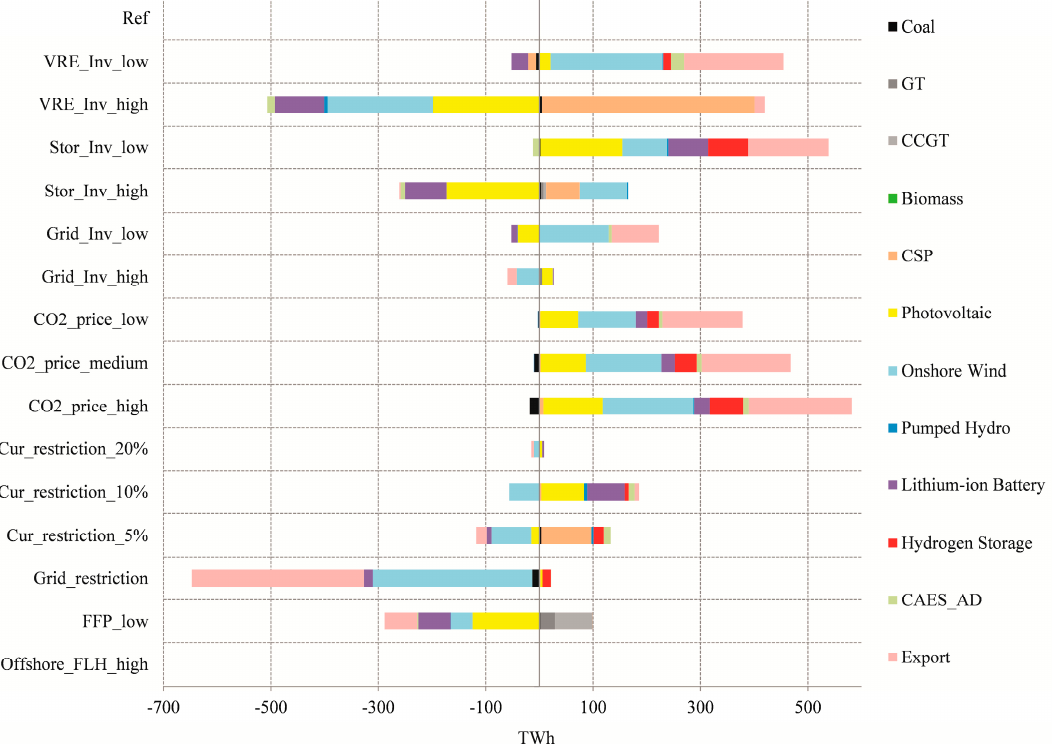
Figure 18. Sensitivity analysis on annual electricity generation in 2050 in Inner Mongolia shown as deviations from the reference scenario.